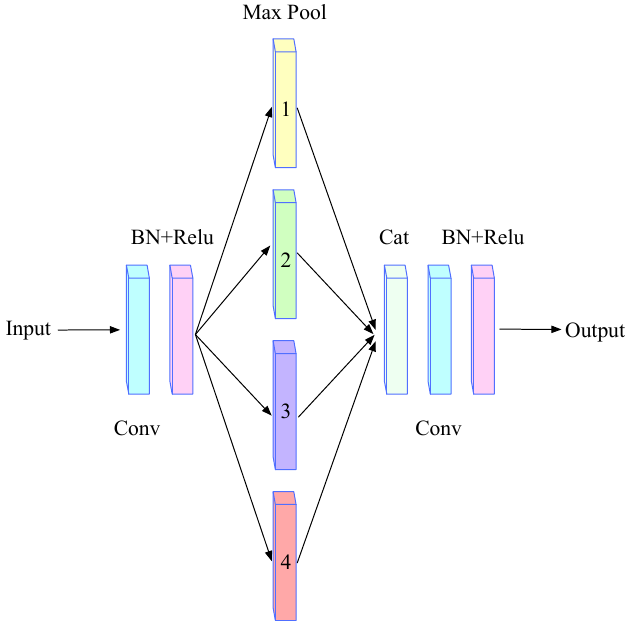
Figure 4. Architecture of HLEM.